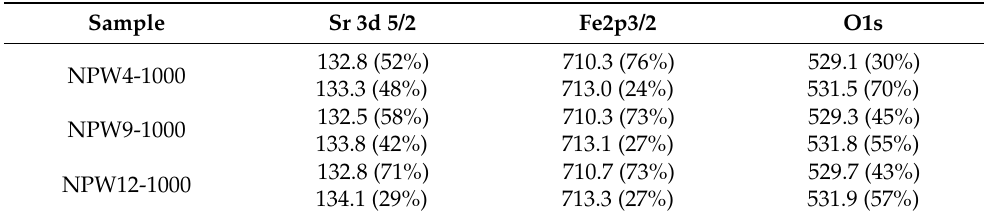
Figure 2. ( A ) Sr 3d 5/2, ( B ) Fe2p3/2 and ( C ) O1s XPS regions for NPW4-1000, NPW9-1000, and NPW12-1000. Table 1. Binding energy and relative abundance of the different components of the Sr 3d 5/2, Fe2p3/2 and O1s XPS regions for NPW4-1000, NPW9-1000, and NPW12-1000 powders.